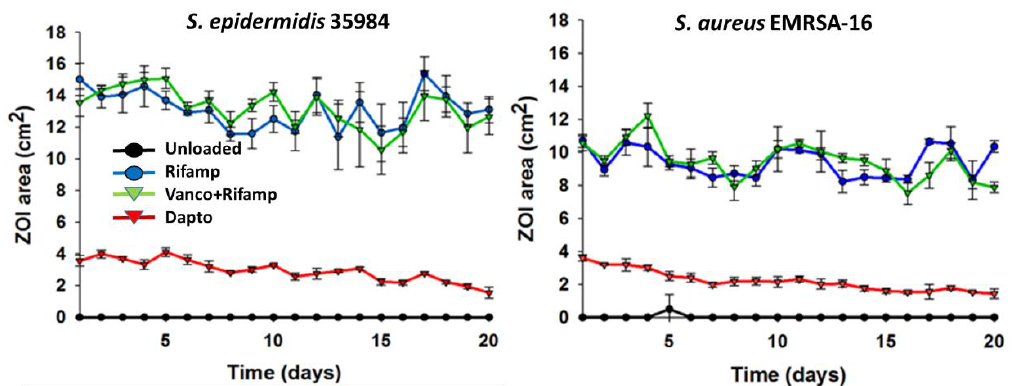
Figure 1. Repeated zone of inhibition (ZOI) of S. aureus NCTC 13143 EMRSA-16 and S. epidermidis ATCC 35984 Stimulan ® beads loaded with rifampicin, rifampicin and vancomycin or daptomycin. Assays were performed in triplicate and data expressed as the mean and 1SD.